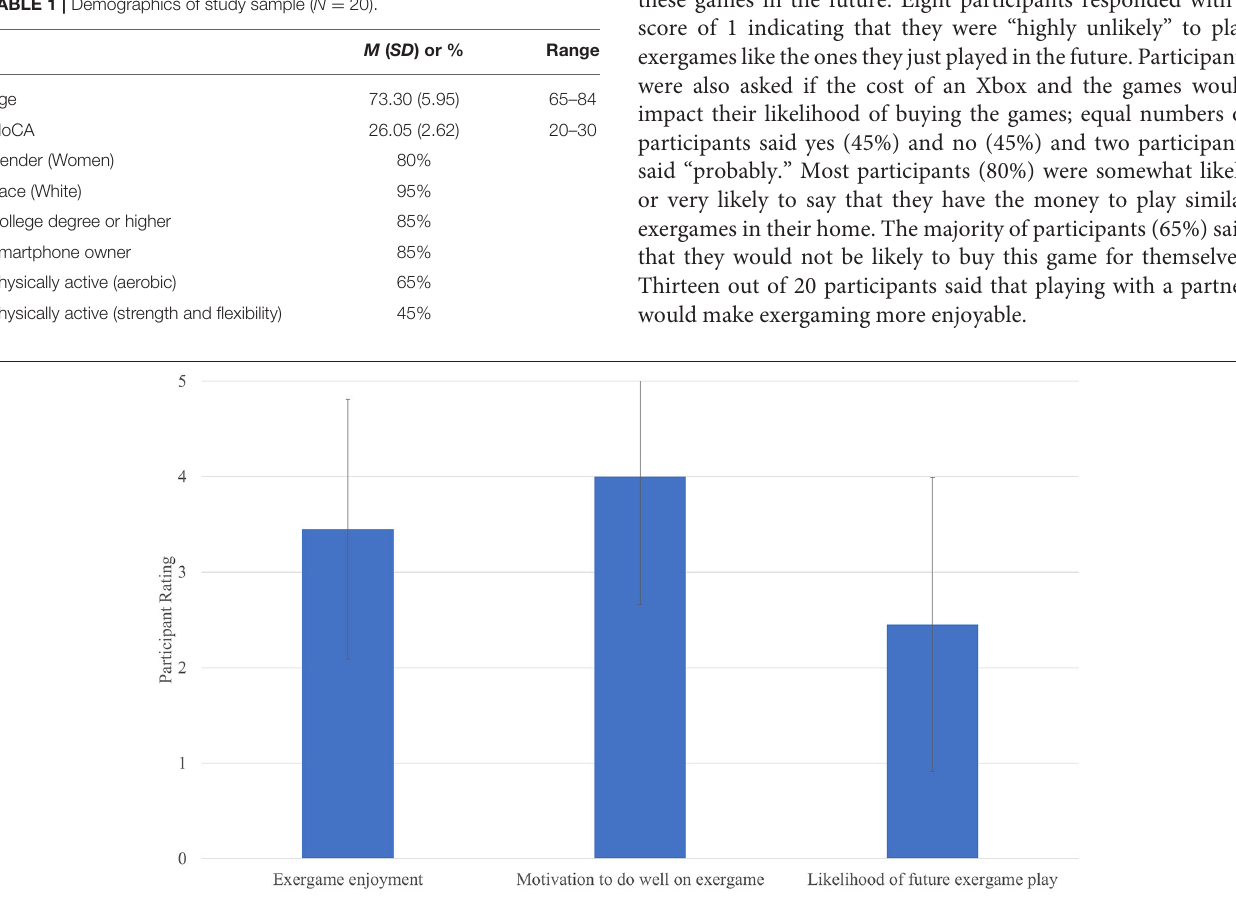
Frontiers in Public Health |